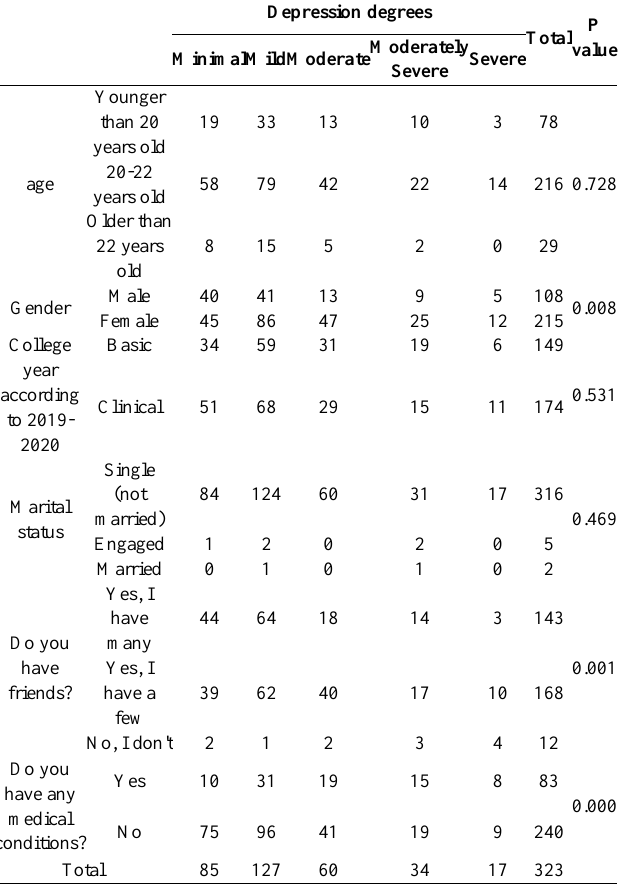
Table 3: P values of Chi-Square and Fisher’s exact Tests for the association between some variables and diagnosis